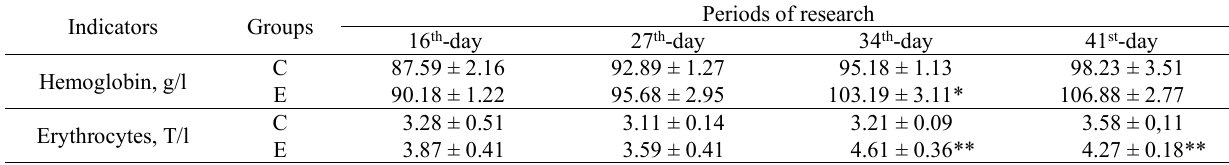
Periods of research